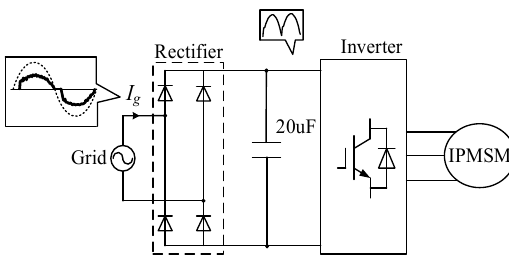
Figure 1. Circuit diagram of the inverter with small DC-link capacitor.